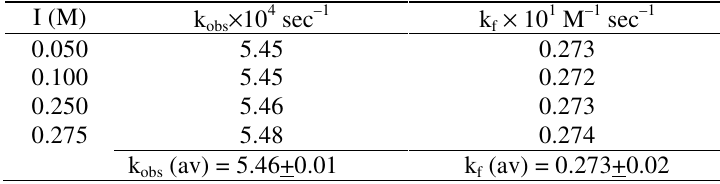
− = 2.0 × 10 -2 M, Temperature = 30±0.1 o C and pH 4